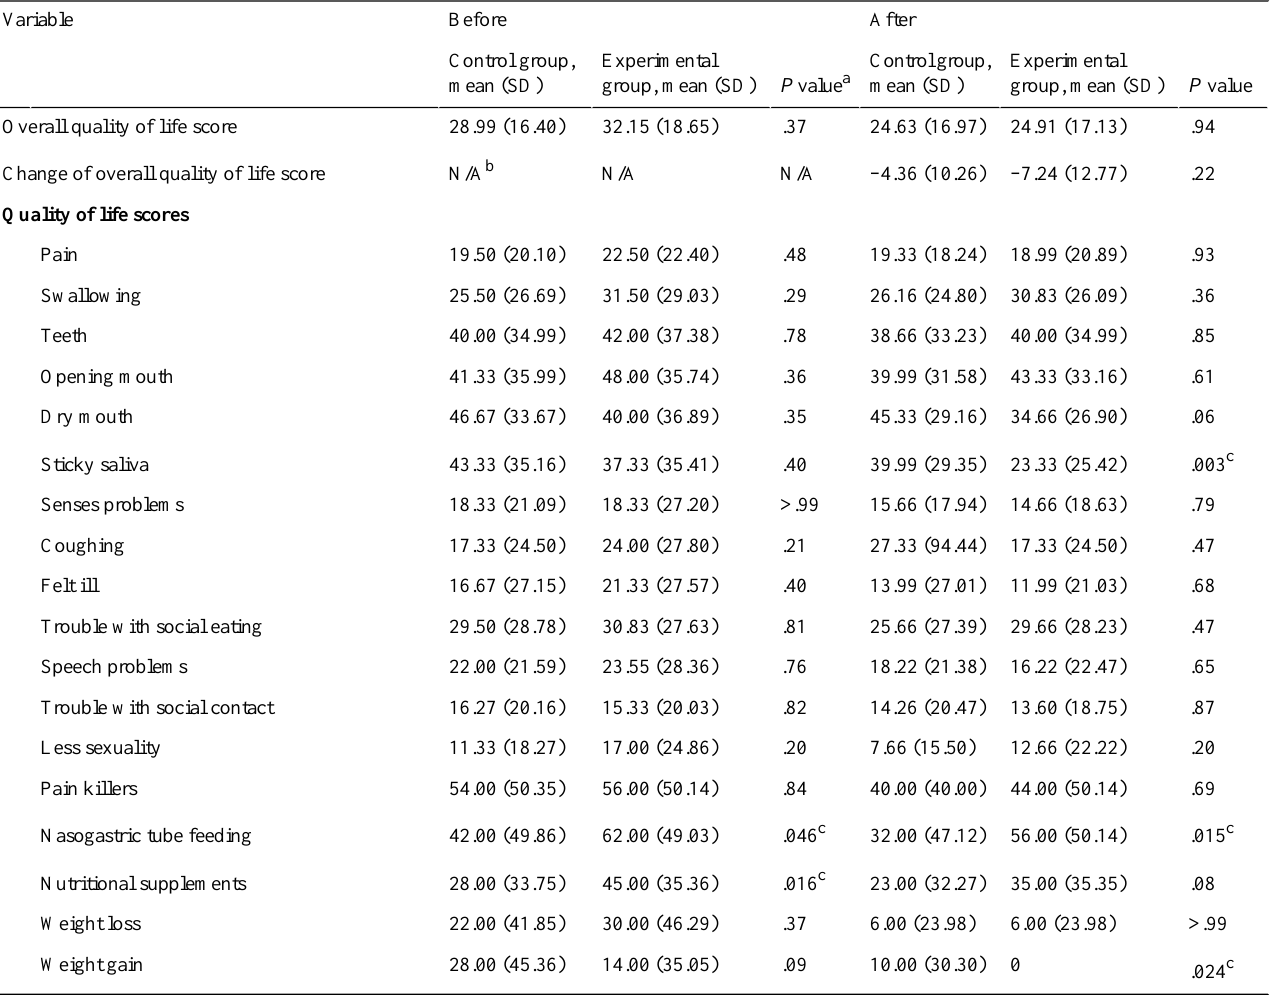
Table 2. Quality of life scores of patients in the study (N=100) before and after the mHealth app intervention measured with the European Organization for Research and Treatment of Cancer Quality of Life Questionnaire Core